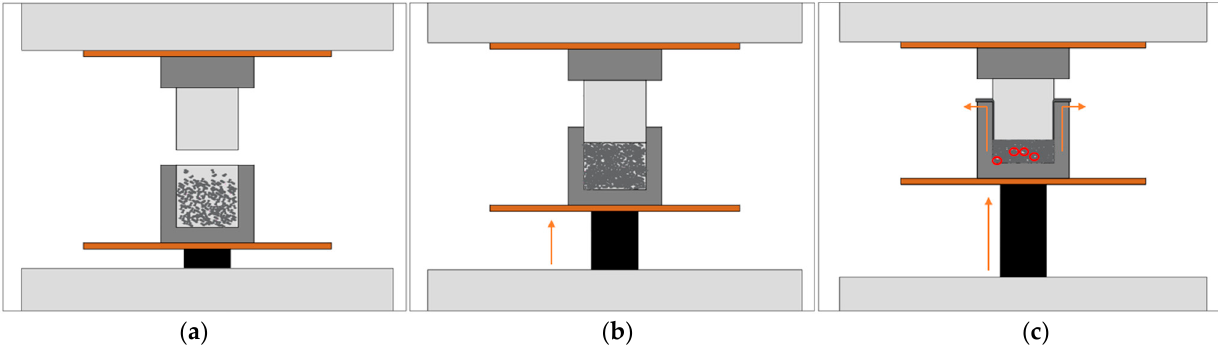
Figure 9. Compression moulding. ( a ) Pellets inside the mould. ( b ) Step 1: Melting the material for 10 min without pressure. ( c ) Step 2: Compression moulding with pressure until material flows out of the mould.